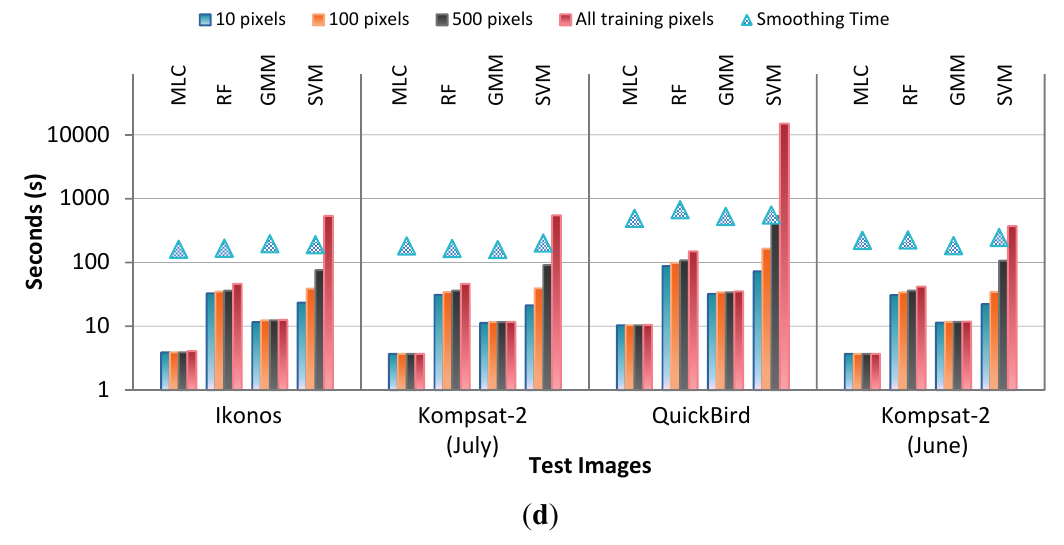
Figure 15. Performance vs. training size. ( a ) Without any smoothing, ( b ) with ECS smoothing, and ( c ) parcel-based strategy. ( d ) Speed of processing vs. training size. “All training pixels” refer to: 48,825; 43,543; 135,752, and 14,251 pixels for the Ikonos, Kompsat-2 July, QuickBird and Kompsat-2 June images,